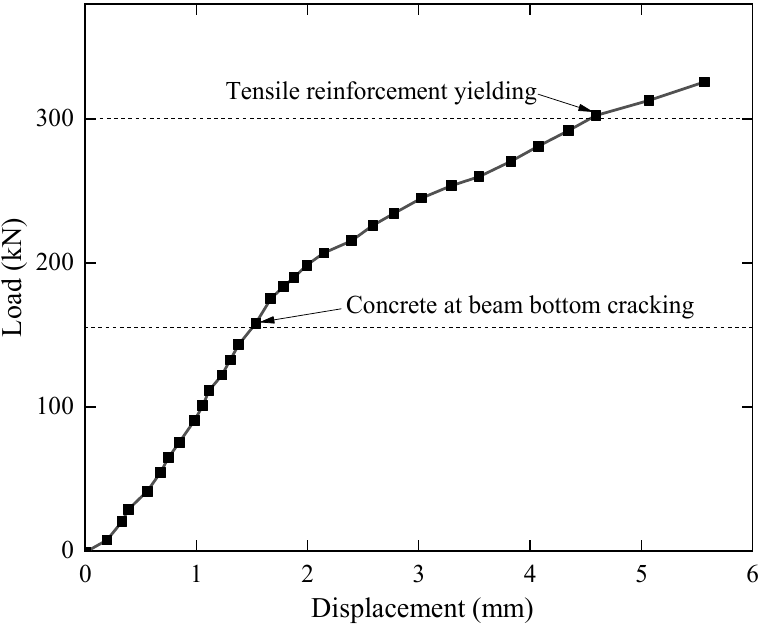
Figure 5. The load-displacement curve of the beam under static loading.